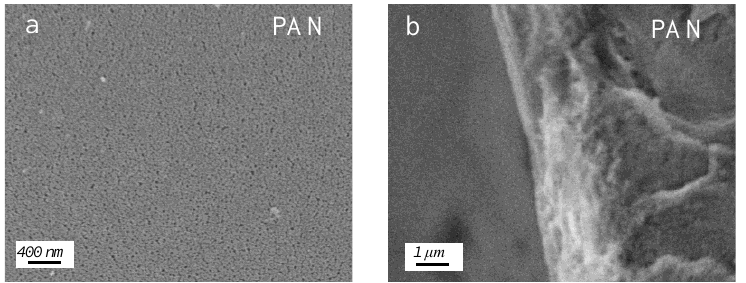
Figure 2. SEM images of PAN UF membrane: ( a ) surface morphology and ( b ) cross-section morphol- ogy of PAN UF